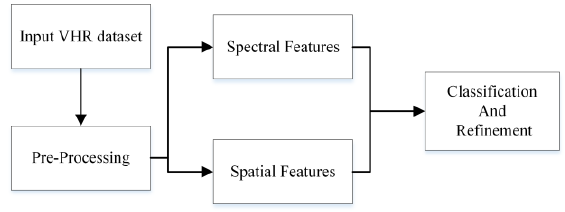
Figure 1. Typical framework of the semantic labeling